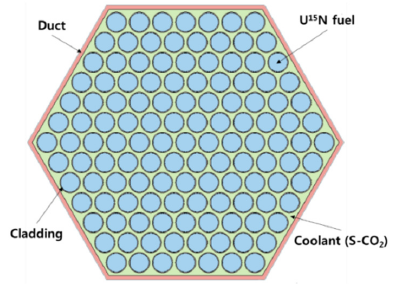
Figure 3. Fuel assembly configuration of the KAIST MMR. Table 2. Fuel assembly design parameters of the KAIST MMR. Oxide dispersion ‐ strengthened: ODS.